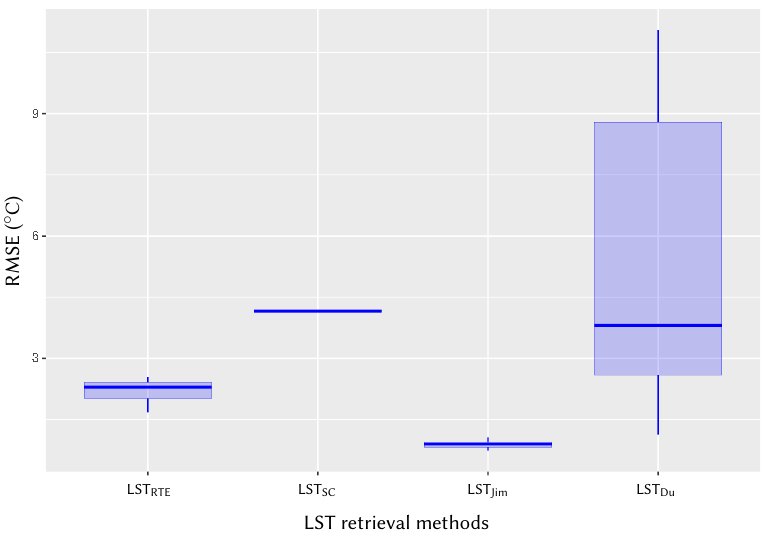
Figure 8. Box plots showing RMSEs of four LST retrieval algorithms as estimated on the Landsat 8 image of 21 February 2018.